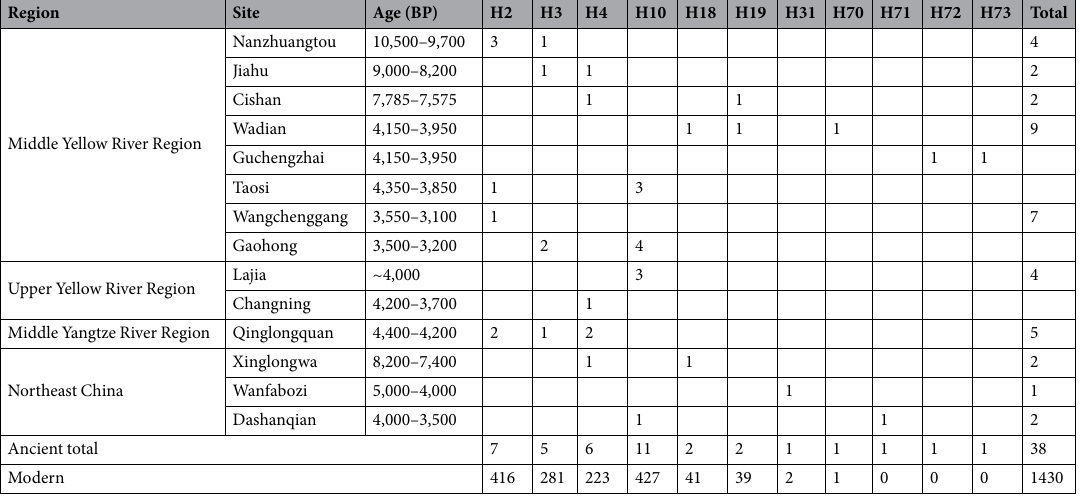
Table 1. Haplotype composition of ancient samples for control region